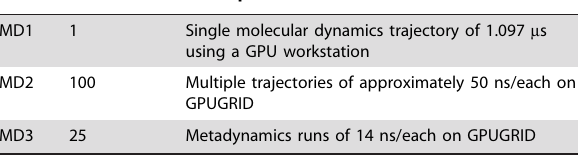
Table 1. Details of the performed MD